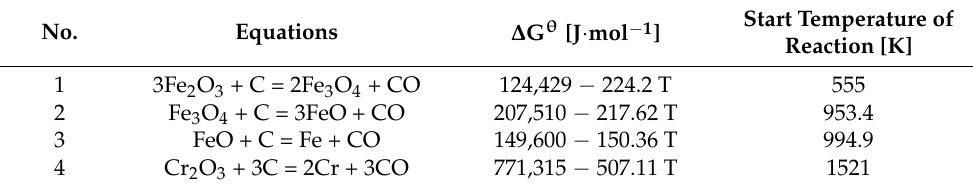
Table 1. Thermodynamic data for reduction